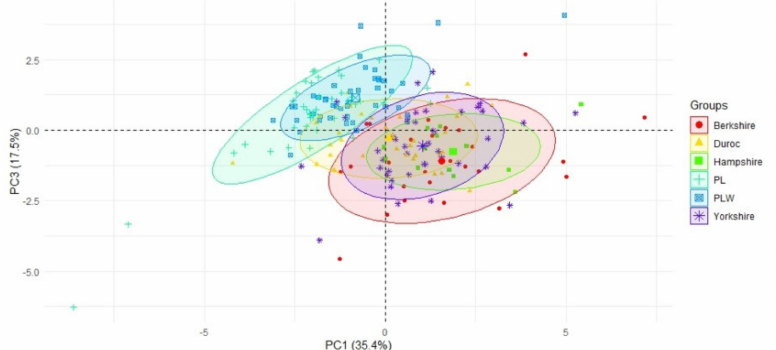
Figure 2. A scatterplot of the first PC against the third PC, with the indication of the breeds. The first PC was correlated with the number and percentage of piglets born alive per litter and with the number of weaned piglets per litter (negative correlation), and the percentage of stillborn piglets per litter (positive correlation), while the third PC was correlated with the total number of born piglets per litter (positive correlation). Axes represent loadings onto components 1 and 3.